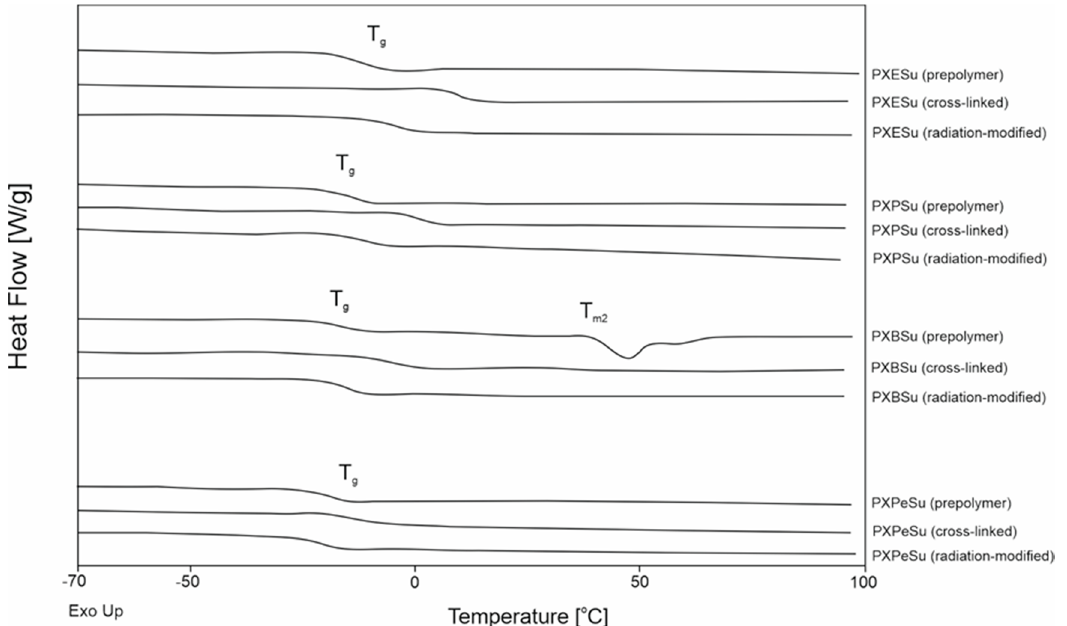
Figure 8. Differential scanning calorimetry (DSC) thermograms for first-heating of PXESu, PXPSu, PXBSu, PXPeSu prepolymers and polymer crosslinked and polymer after radiation modified.